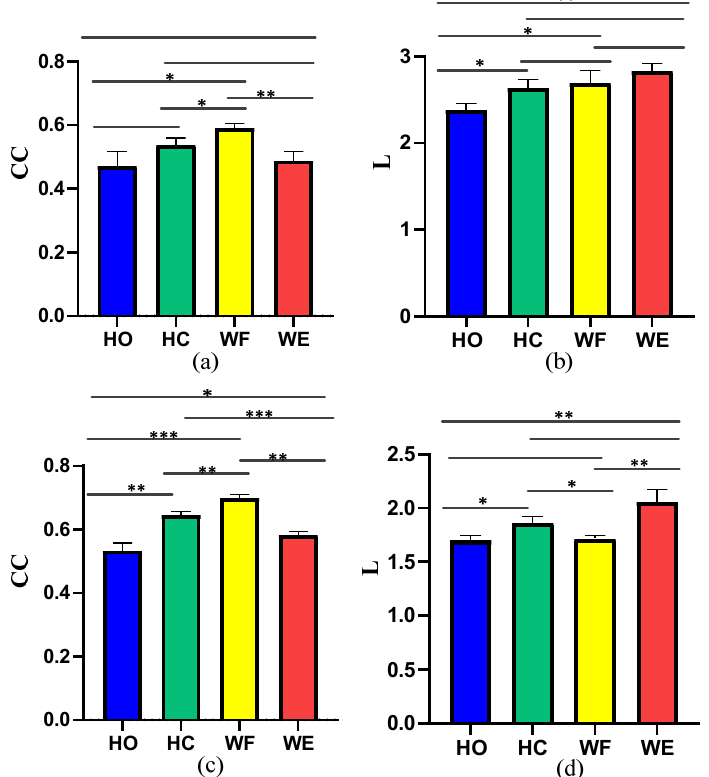
Figure 9. Clustering coefficient (CC) and characteristic path length (L) of the network for the different motor activities considered: ( a ) CC obtained with GC, ( b ) L obtained with GC, ( c ) CC obtained with vine copula, ( d ) L obtained with vine copula. (* means p < 0.05, ** means p < 0.01,*** means p < 0.001).